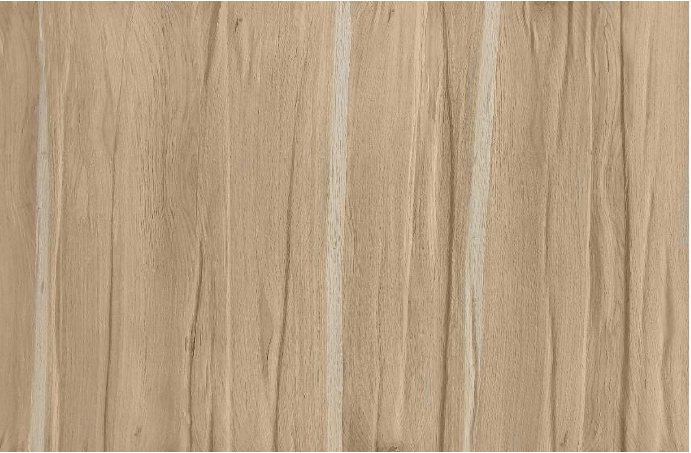
Figure 4. Design of a decorative wall panel from veneer residue created by multi-layer pressing and gluing (© Domagoj Mamić, 2022).